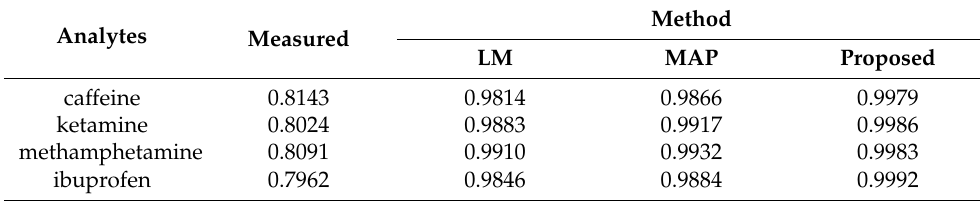
Table 5. The results of the CC of each